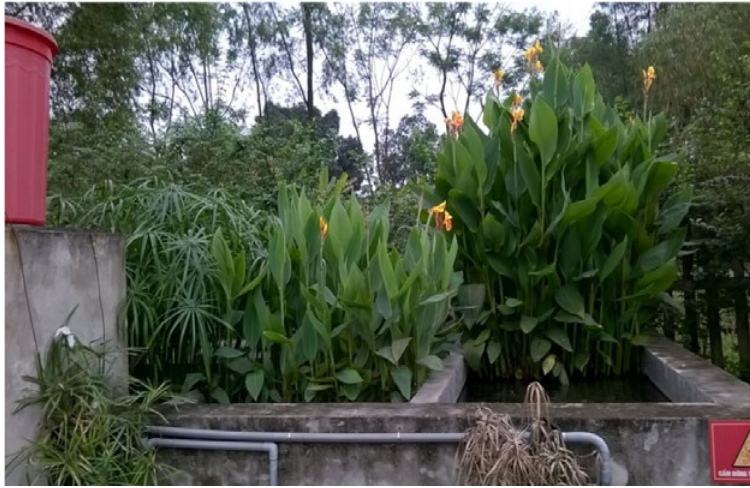
Fig. 5: Canna generalis on 12/4/2016 in HSSF CW (left) and FSW CW